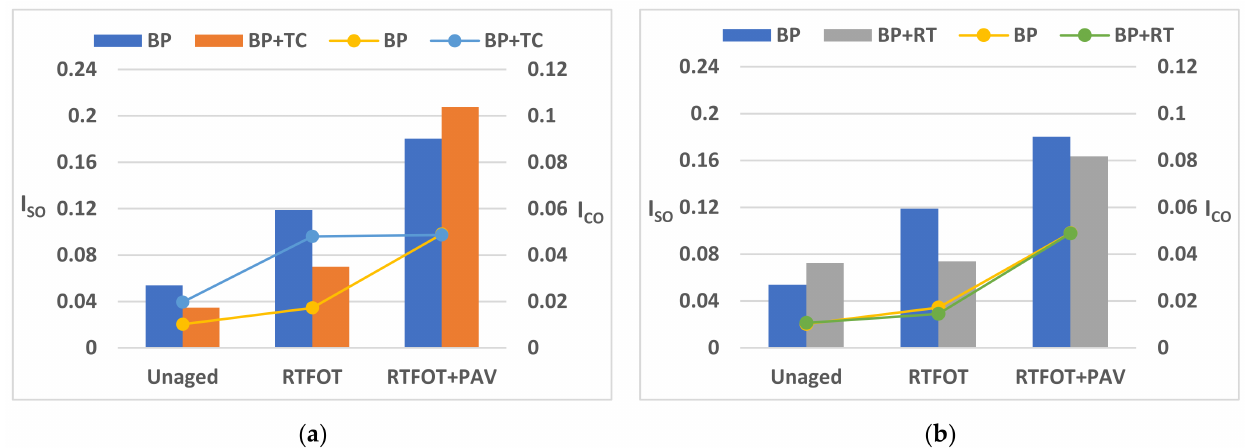
Figure 12. Carbonyl index (curve) and sulfoxide index (grouped histogram) values at every ageing stage of ( a ) BP and BP + TC; ( b ) BP and BP +